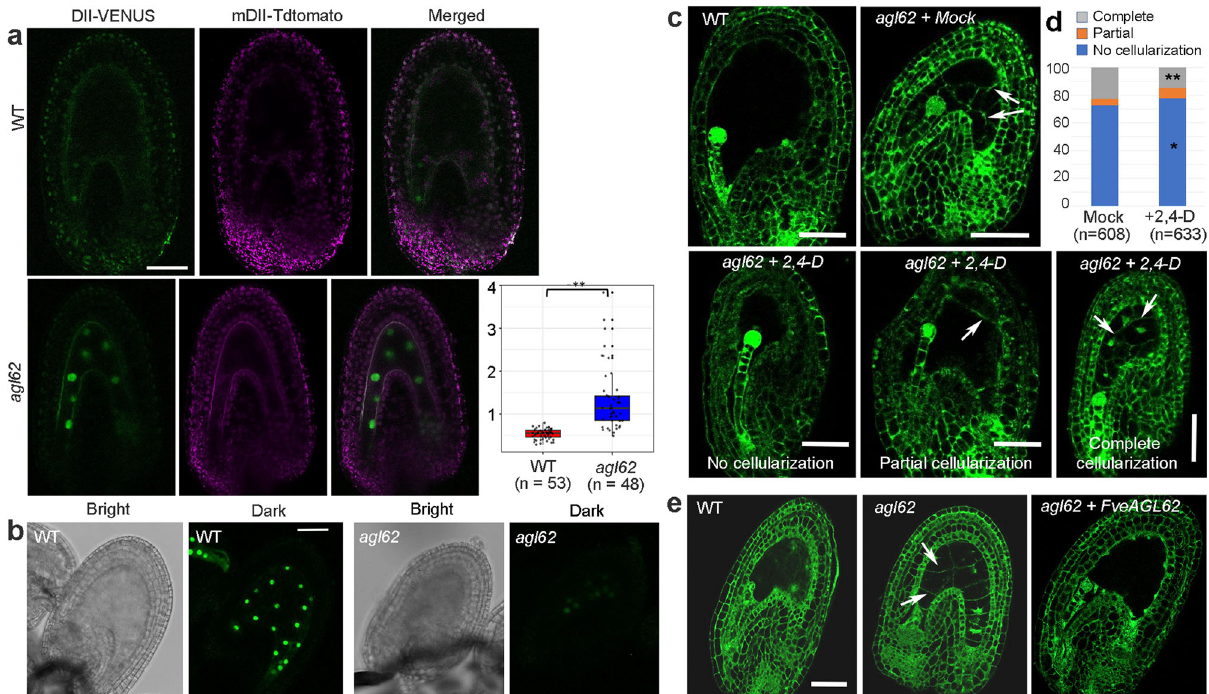
Fig. 3 Arabidopsis atagl62 endosperms have reduced auxin when compared with WT. a Confocal image of auxin reporter R2D2 in WT (Col-0) and atagl62-2 seeds at 2 DPA. Absence of DII-VENUS nuclear signal in the WT endosperm contrasts with strong DII-VENUS nuclear signals in the atagl62-2 endosperm. The scatter graph Y-axis indicates the ratio between DII-VENUS and mDII-Tdtomato signal per endosperm nucleus. A second independent experiment gave a silimar result. The elements of boxplots and source data are provided in the Source Data fi le. Signi fi cant difference indicated by ** ( P = 7.55e-12 by two-tailed Student ’ s t -test) is found between WT and atagl62 . b Confocal image of ProAtYUC10::3xnGFP signal in WT and atagl62 endosperms. Note the strong nuclear GFP signals in the WT endosperm and almost undetectable GFP signals in the atagl62 endosperm. c Confocal image of WT and atagl62 mutant seeds at 2 DPA either mock-treated or auxin (2,4-D)-treated. Different extent of endosperm cellularization is observed. Arrows indicate cell walls between endosperm cells. d Quanti fi cation of mock- or 2,4-D-treated seeds derived of atagl62-2 ( − / + ) parents. Y-axis is the percentage of endosperms with one of the three phenotypes: no cellularization, partial cellularization, and complete cellularization. Signi fi cant difference (two-tailed Fisher ’ s exact test) is indicated by ** ( P = 0.0006) for complete cellularization or * ( P = 0.0416) for no cellularization between mock and 2,4-D treatments of each phenotypic category. e Confocal image of Arabidopsis seeds at 2 DPA. Precocious endoserpm cellularization is absent in transgenic atagl62 plants containing the strawberry FveAGL62 gene. Scale bar in a – e : 50 μ